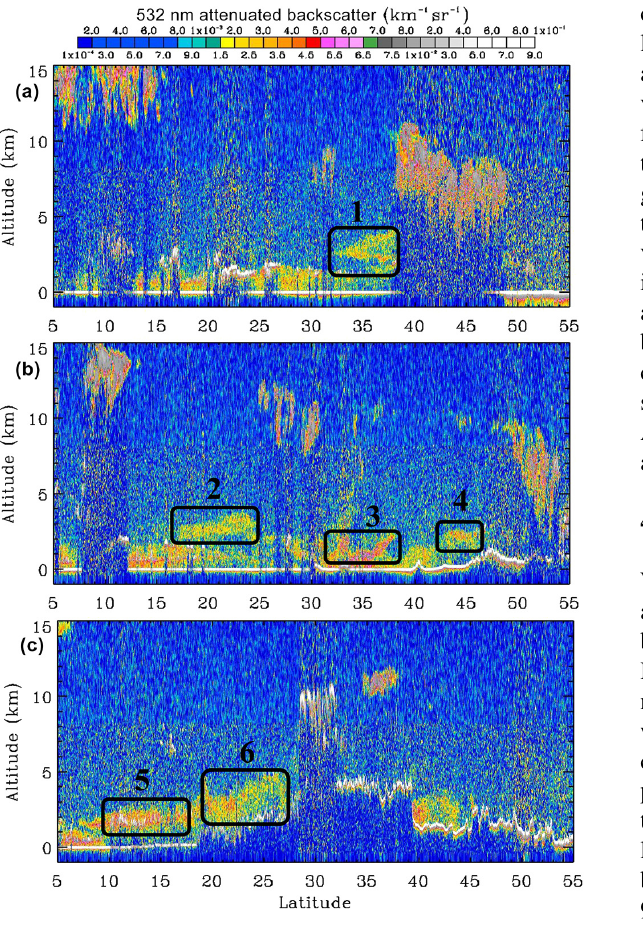
Figure 4. All panels show CALIOP 532nm attenuated backscat- ter profiles on 18 March 2014. CALIPSO transects are indicated in Fig. 4c (black lines), which are increasing in time from east to west with (a) at about 03:20UTC, (b) at about 05:00UTC, and (c) at about 06:40UTC. Boxes highlight regions of interest. The locations of these boxes along the CALIPSO transects are also indicated in Fig.